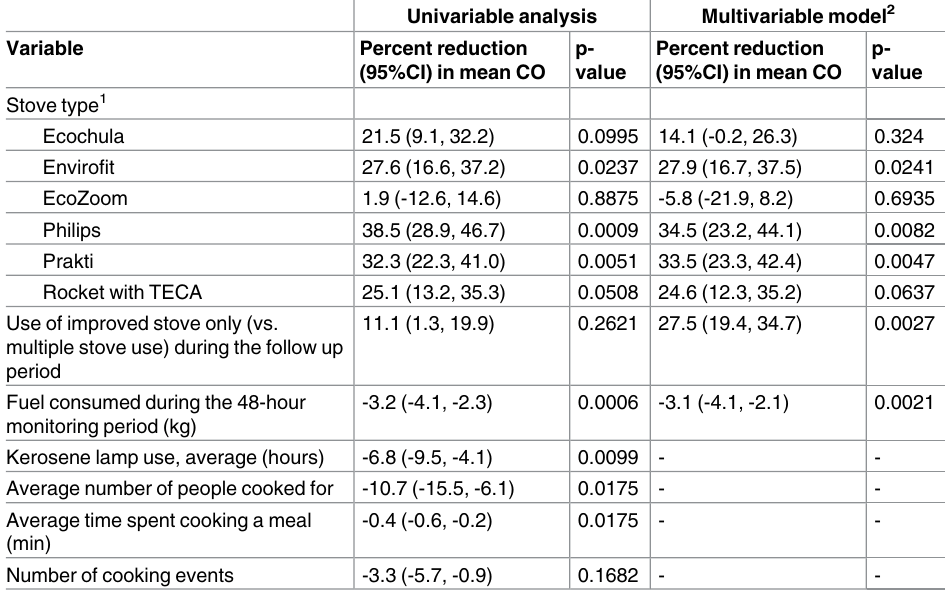
Table 5. Factors associatedwith 48-hour mean real-time kitchen CO (ppm)